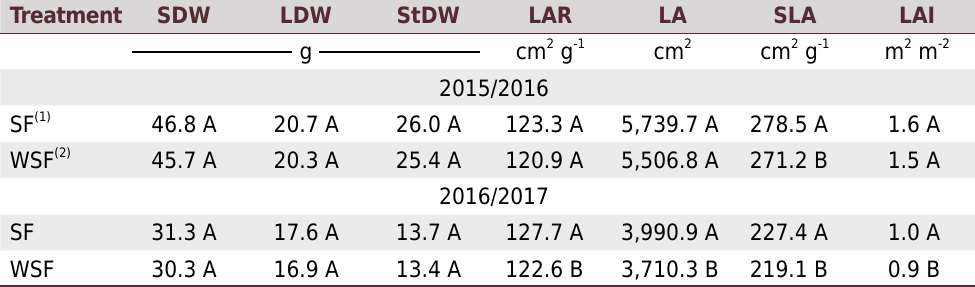
Table 1. Means of biometric parameters for the sowing fertilization factor Treatment